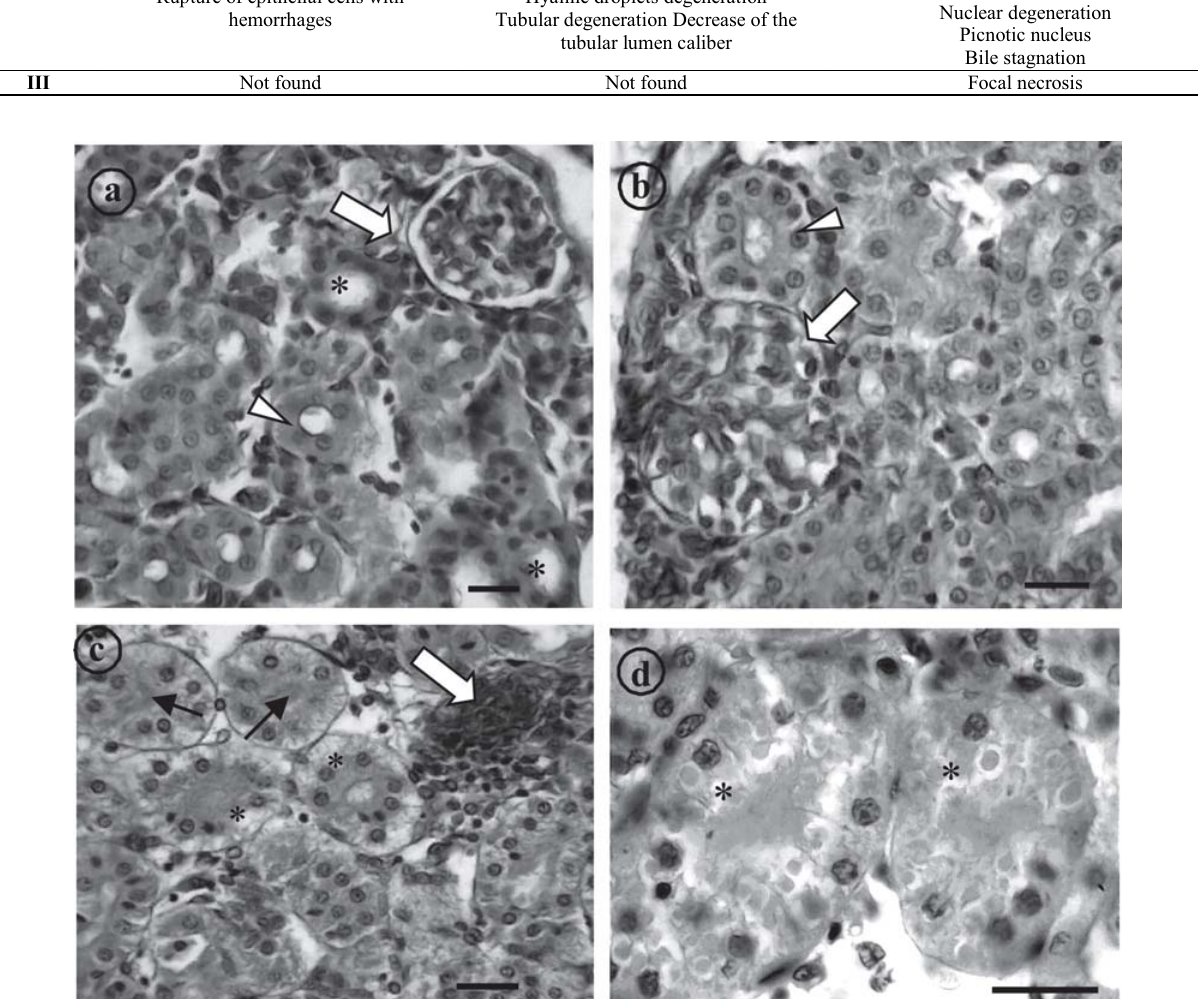
Fig. 3. Photomicrographs of the kidney of P. lineatus caged in Cambé stream. a) normal renal corpuscle showing the glomeru- lus and the Bowman’s space well defined (arrow), proximal tubules (*), distal tubules (arrowheads); b) glomerular expansion and absence of the Bowman’s space (arrow) and tubule cells with hypertrophied nucleus (arrowheads); c) tubule starting the regeneration process (white arrow), occlusion of the tubular lumen (black arrows) and cloudy swelling degeneration (*); d) detail of 2 tubules with hyaline droplets degeneration (*). Scale bar 10 mm,